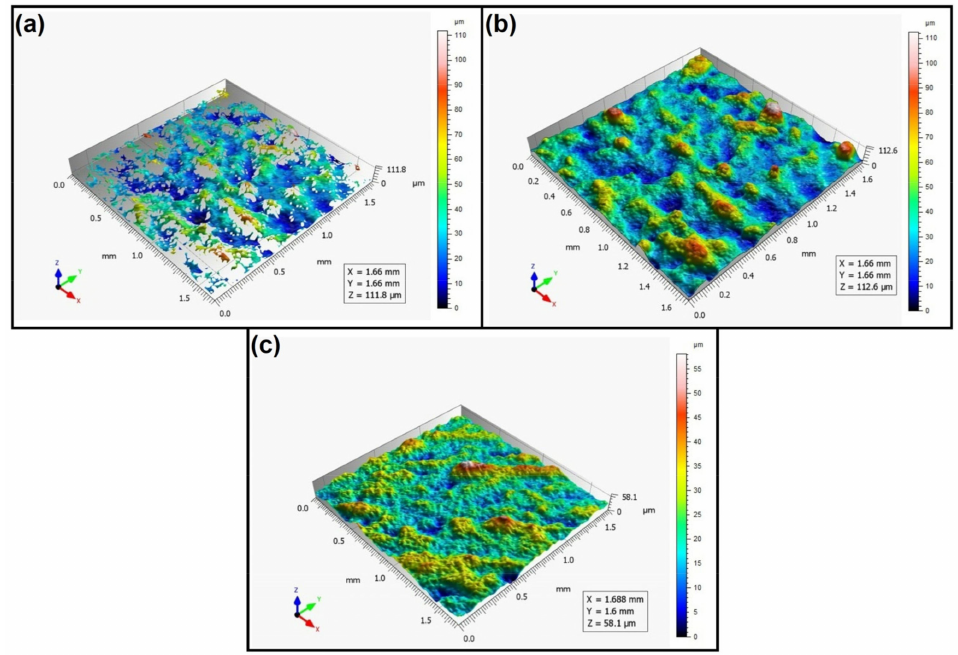
Figure 12. Surface topography of the element 3D printed using SLM technology (Pd = 0 ◦ ). ( a ) Talysurf CCI—without filling non-measured points, ( b ) Talysurf CCI—after filling non-measured points, ( c ) Talysurf PGI 1230.